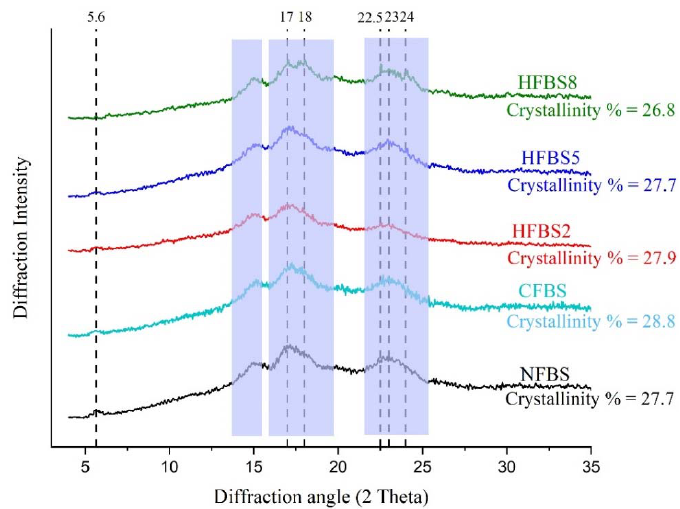
Figure 3. XRD patterns and relative crystallinity of native and hydrolyzed faba bean starches. Regions highlighted in color are the most affected peaks. NFBS, native faba bean starch; CFBS, conventional hydrolysis faba bean starch; HFBS2, HFBS5, and HFBS8, hydrolyzed faba bean starches.